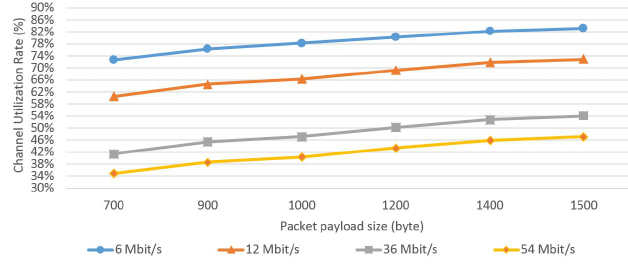
Figure 5: Channel utilization rate in Scenario